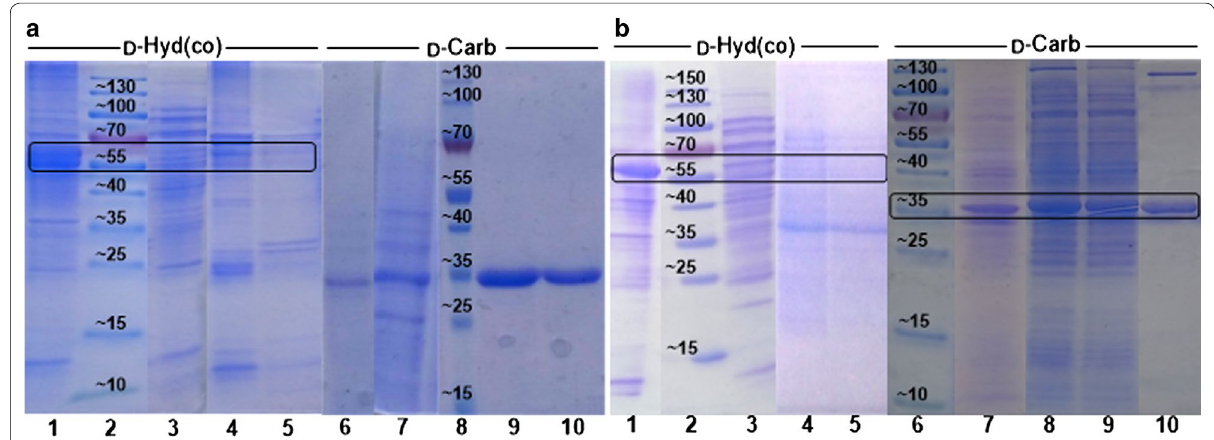
Fig. 7 SDS-PAGE analysis of different fractions after purification of both enzymes. a Ni Sepharose beads 1 – 5 hydantoinase, 1 insoluble fraction, 2 protein standard with molecular weights in kDa, 3 crude extract, 4 eluate 1, 5 eluate 2, 6 - 10 carbamoylase, 6 insoluble fraction, 7 crude extract, 8 protein standard with molecular weights in kDa, 9 eluate 1, 10 eluate 2. b Functionalized magnetic beads, 1 – 5 hydantoinase, 1 insoluble fraction, 2 protein standard with molecular weights in kDa, 3 crude cell extract, 4 wash 1, 5 eluate 6 – 10 carbamoylase, 6 protein standard with molecular